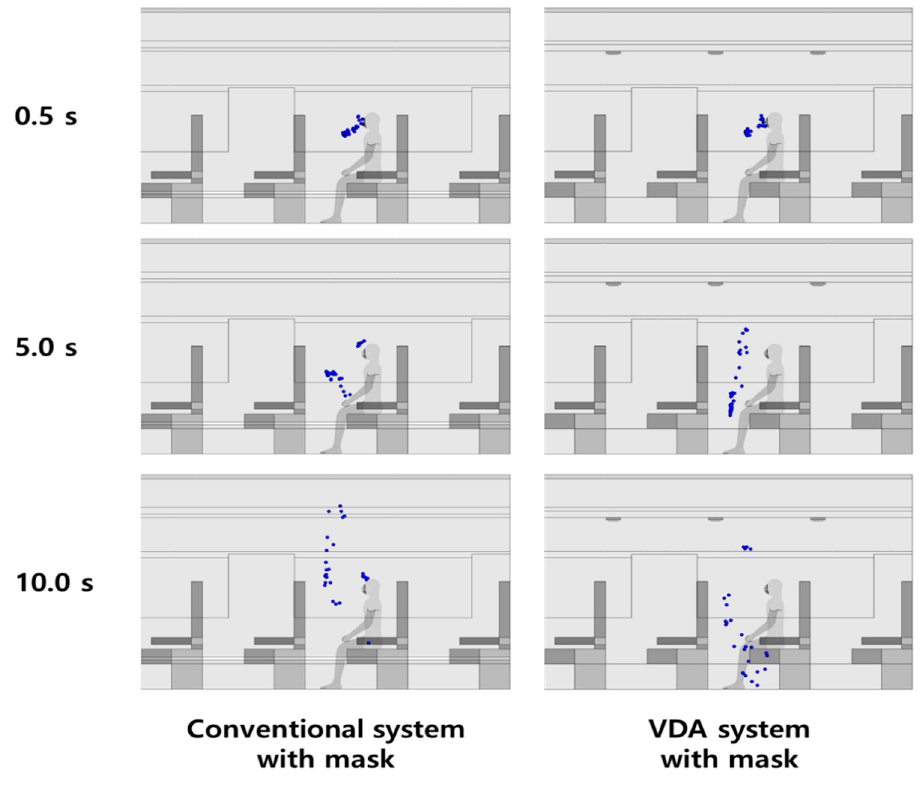
Figure 12. Droplet distributions in the conventional and VDA systems with a mask between 0 and 10 s after coughing. The droplet size is uniform.